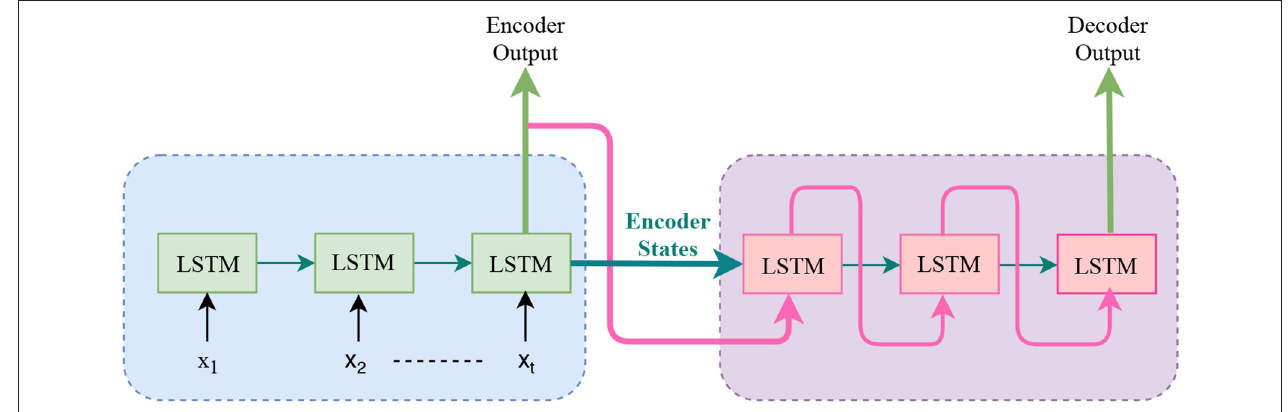
FIGURE 5 | Sequence to Sequence model: This mode uses “encoder-decoder” and maps input sequence with “encoder states” and use it as initial state of the